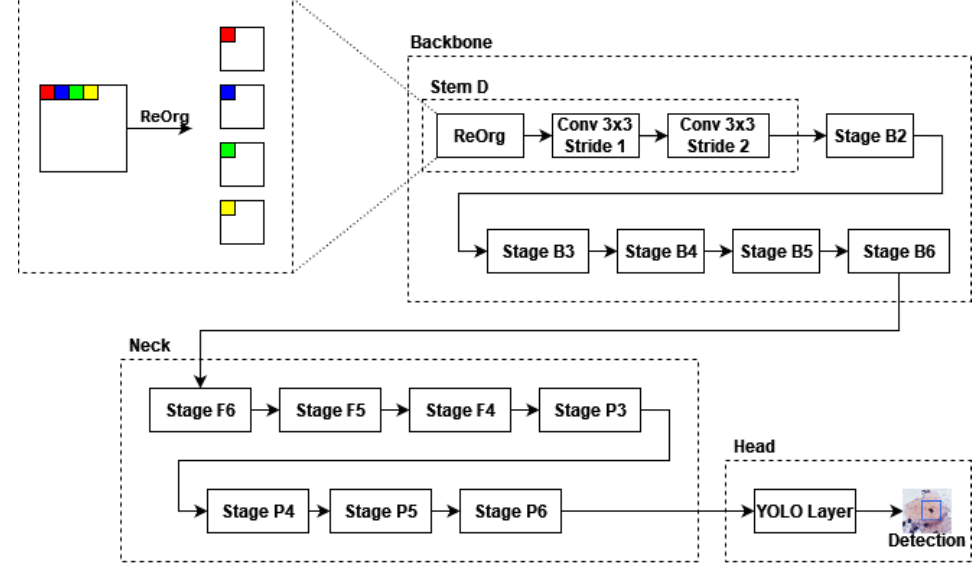
Figure 1. YOLOR architecture, adapted from Wang et al.